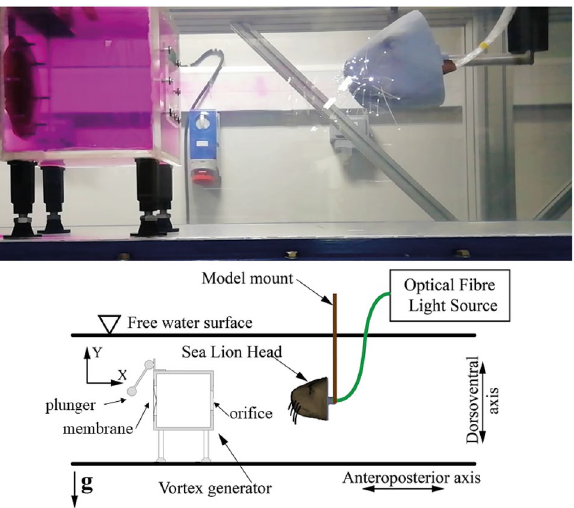
Figure 1. Top: Picture of the experimental setup showing the vortex ring generator filled with pink dye, 200 mm away from the model of the sea lion head with its 3D array of whiskers. Bottom: principle sketch of the experiment, including the definition of the body axes.